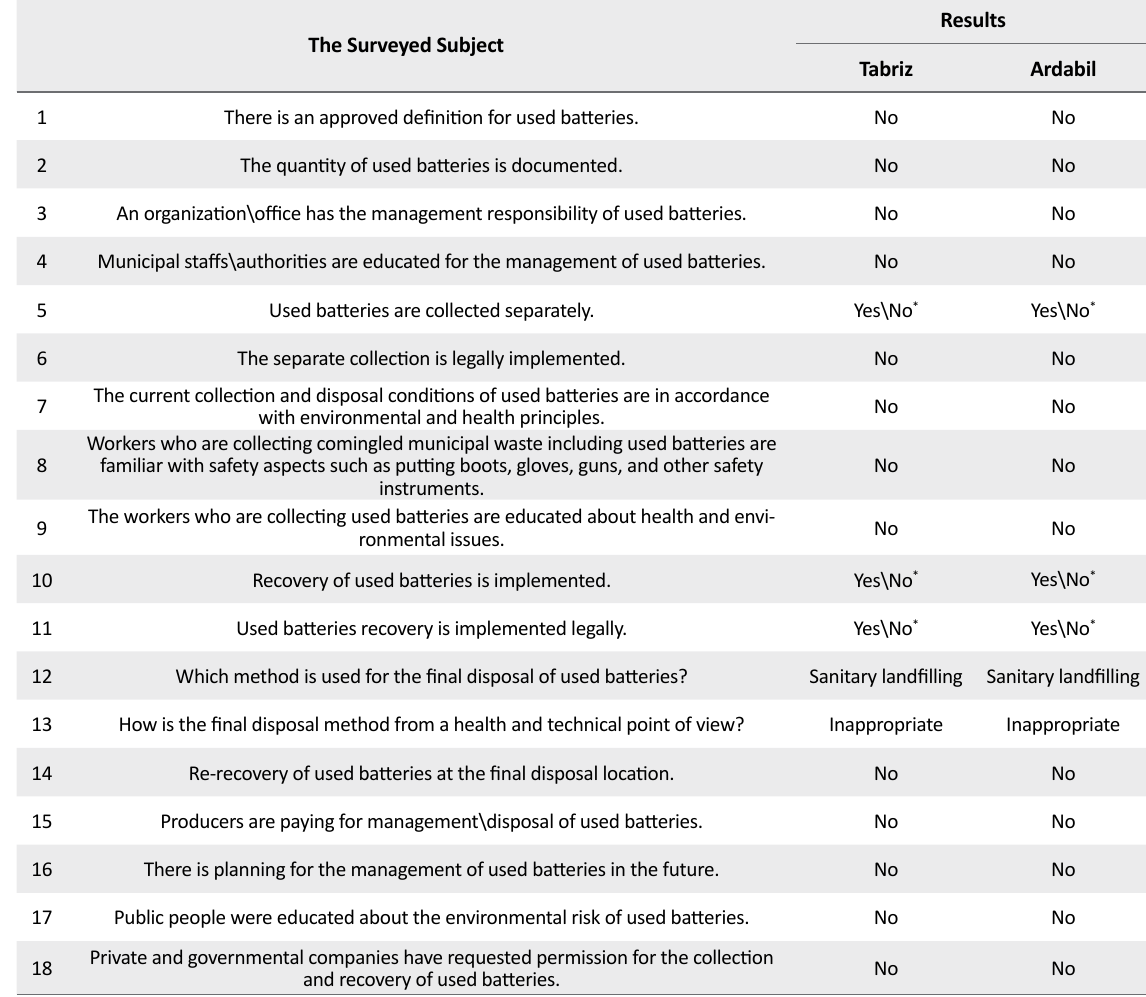
Table 7. Summary of the current condition of used batteries’ management in Tabriz and Ardabil